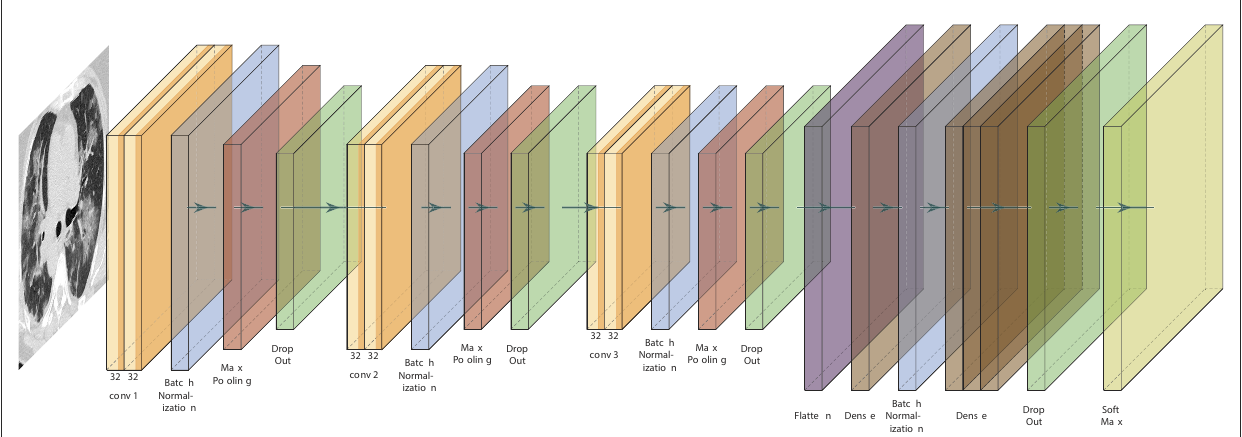
FIGURE4 Developed architecture for COVID-19 diagnosis classification models based on CT chest images and convolutional neural network architectures. Three blocks of layers composed of convolution, batch normalization, max pooling and dropout layers are generated as a pattern extraction strategy, then a flatten layer is used to generate the inputs to the dense layers, which are joined with a layer of batch normalization, followed by three additional full connected layers, which end with a new dropout layer to prevent overfitting, and the final classification layer. ReLU is used as activation functions and the SoftMax function in the classification layer. Finally, the Adam optimizer is used as a loss function binary cross entropy. The developed architecture is an update from previous method for CT chest images classification models developed by our group